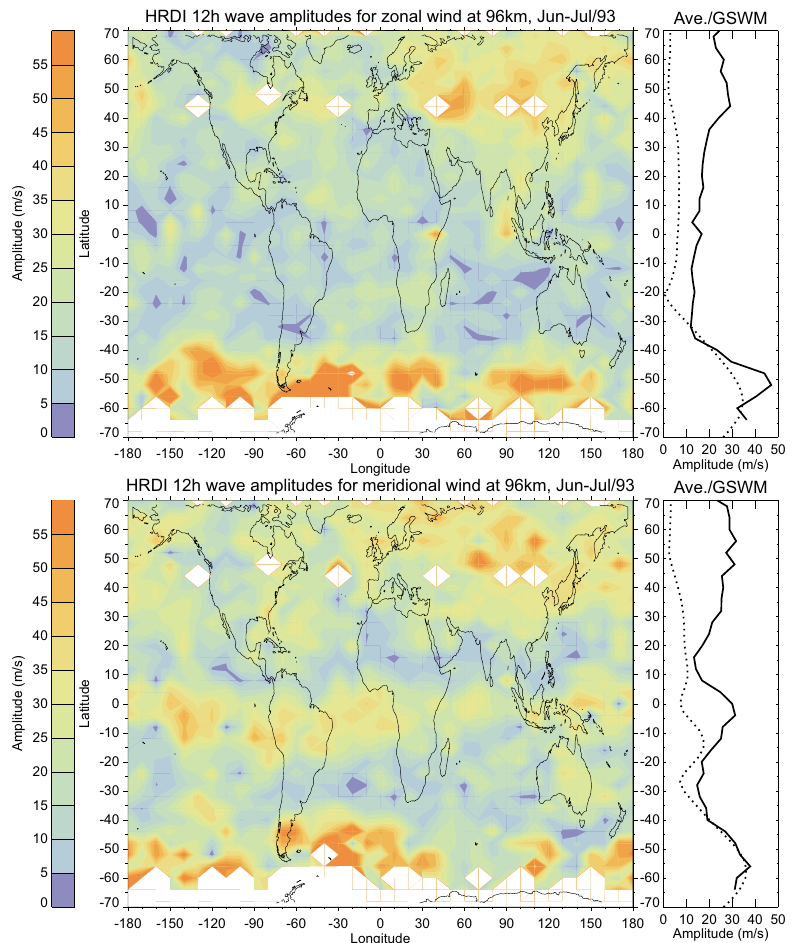
Fig. 7. Contoured plots of 12-h tidal amplitudes for June–July 1993 from HRDI. The longitudinal averages are to the right (solid line), and also the GSWM-2000 values